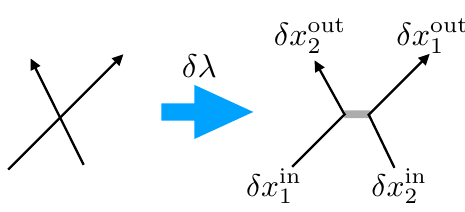
Figure 1 . The effect of the λ -deformation on a two-body scattering process. This illustration, where the fundamental particle gains a positive width δλ , corresponds to a negative scattering shift (or differential scattering phase) ϕ , in the convention of